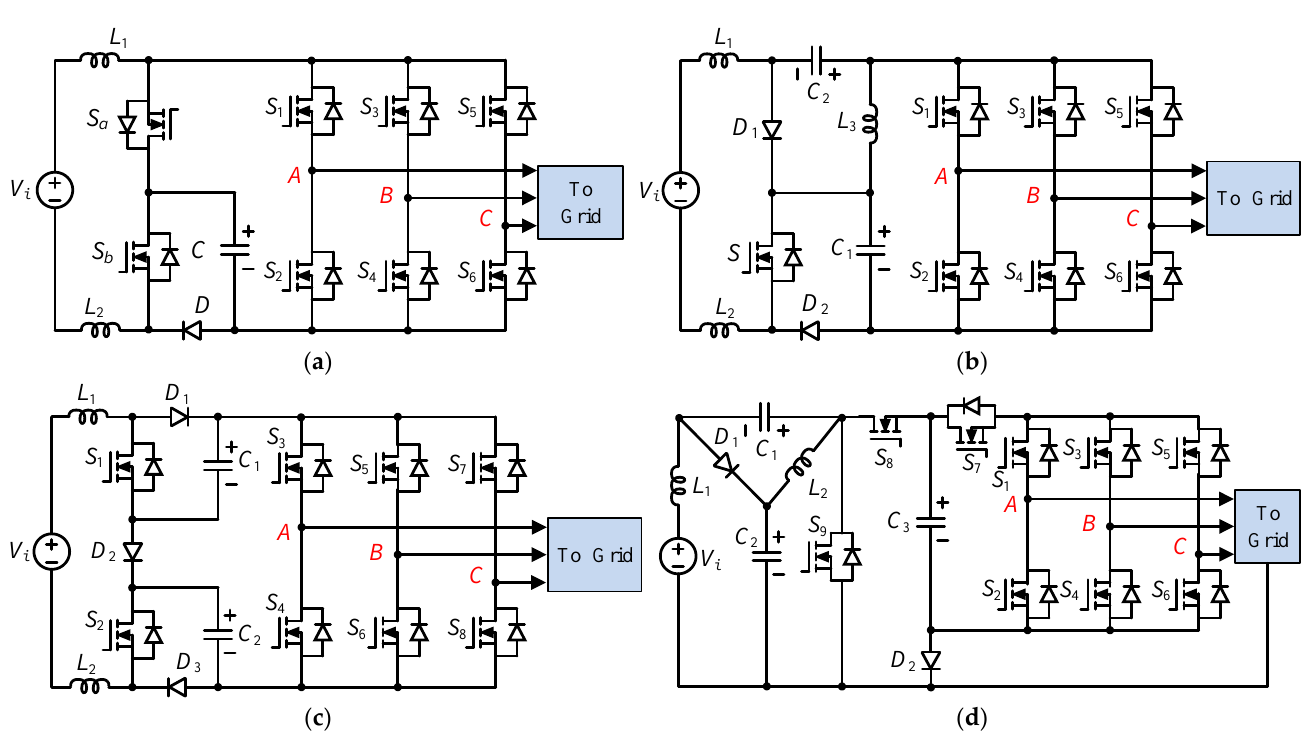
Figure 9. Active impedance-source topologies for CMV reduction. ( a ) MqSBI [80], ( b ) modified- AqZSI [81], ( c ) ISI [82], ( d ) and common-ground AqZSI [83]. The comparison of both passive and active three-phase, two-level transformerless impedance-source-networks-based inverters, in terms of component count, input current profile, modulation index range, boost factor, and variation of CMV, has been given in